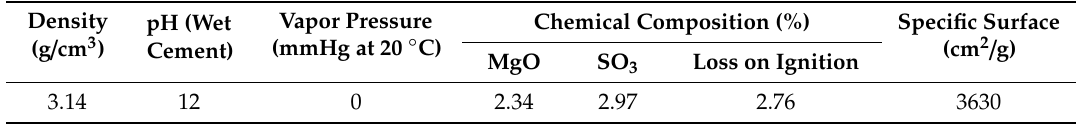
Table 2. Properties of ordinary Portland cement (Type I).